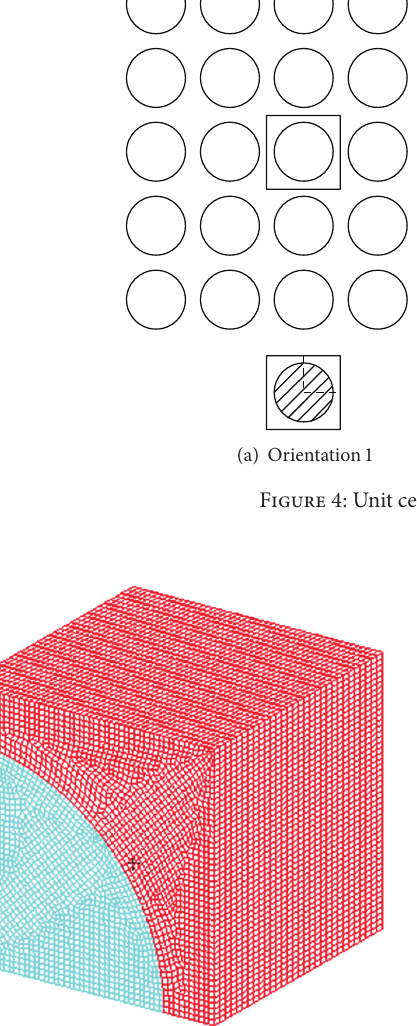
and 𝜎 󸀠 values under uni-axial eqv eqv